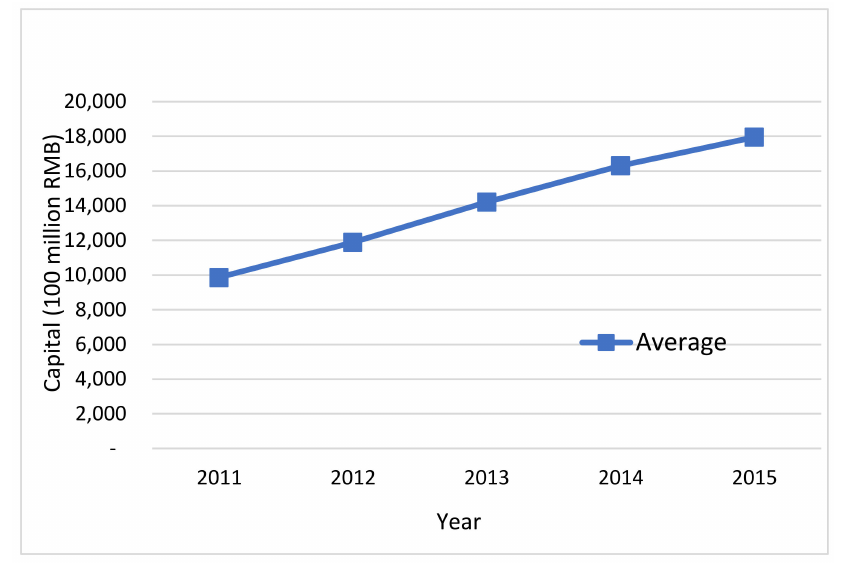
Figure 1. Average capital over 2011–2015 in China.